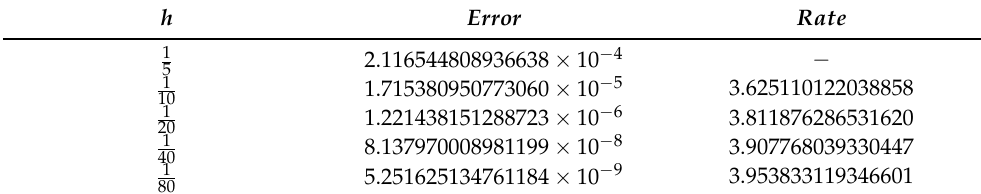
Table 4. Maximum errors and decay rate as functions with h